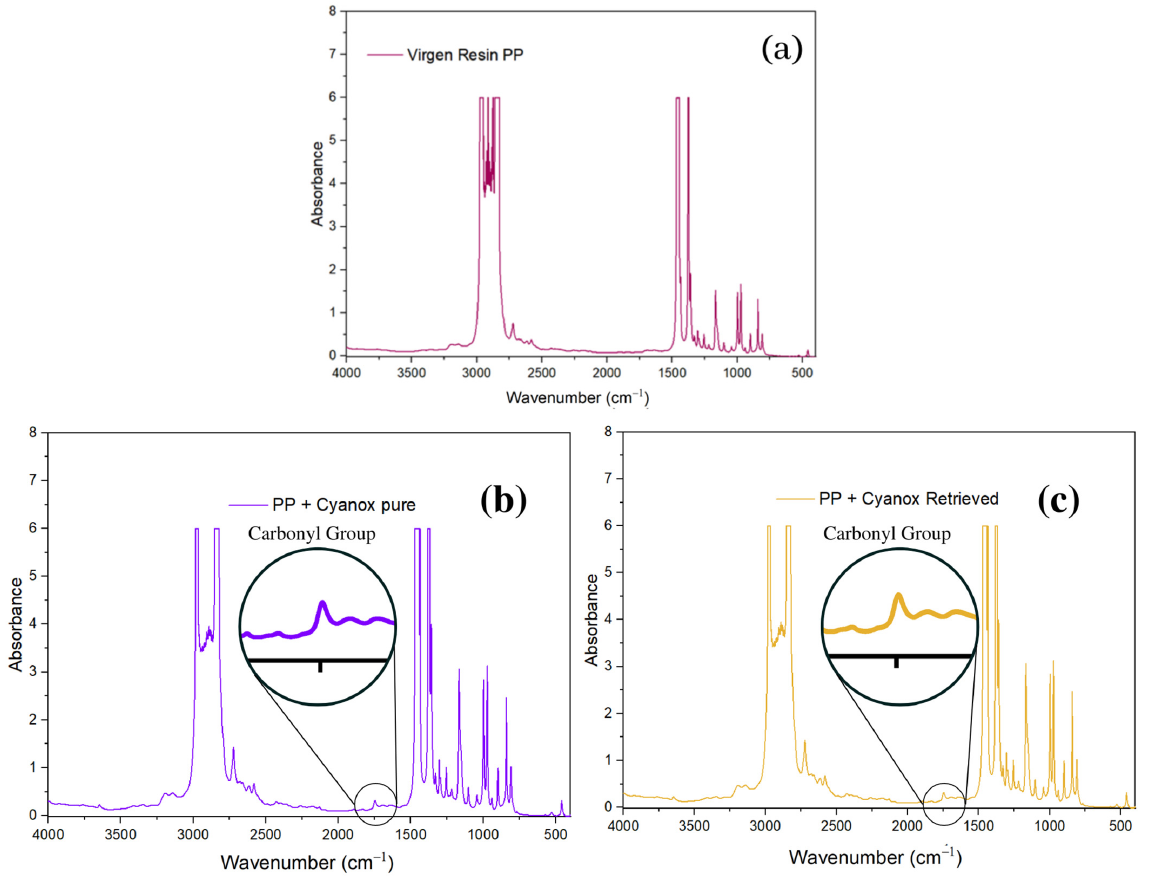
Figure 8. ( a ) Virgin PP infrared spectrum, ( b ) pure PP + Cyanox 1790 infrared spectrum, ( c ) recovered PP + Cyanox 1790 infrared